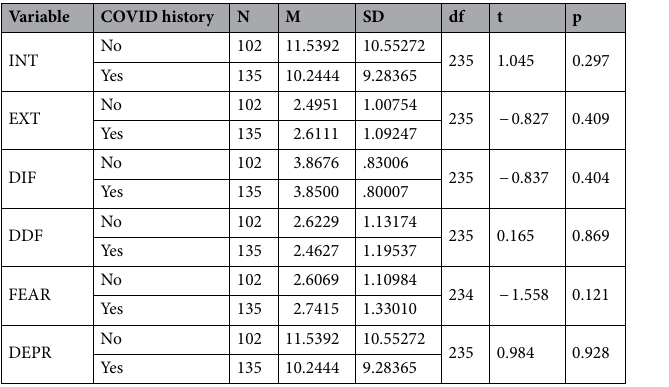
Table 7. Group statistics and ındependent sample test